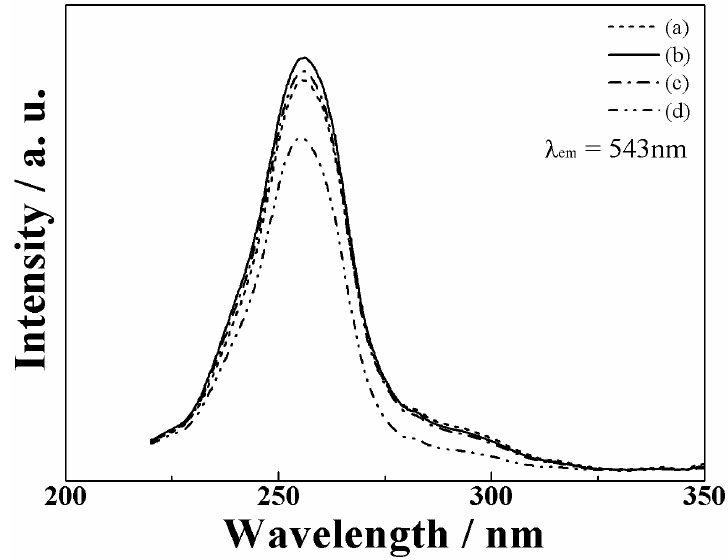
Figure 4. Excitation spectra of the (La (c) 0.10, and (d) 0.15.